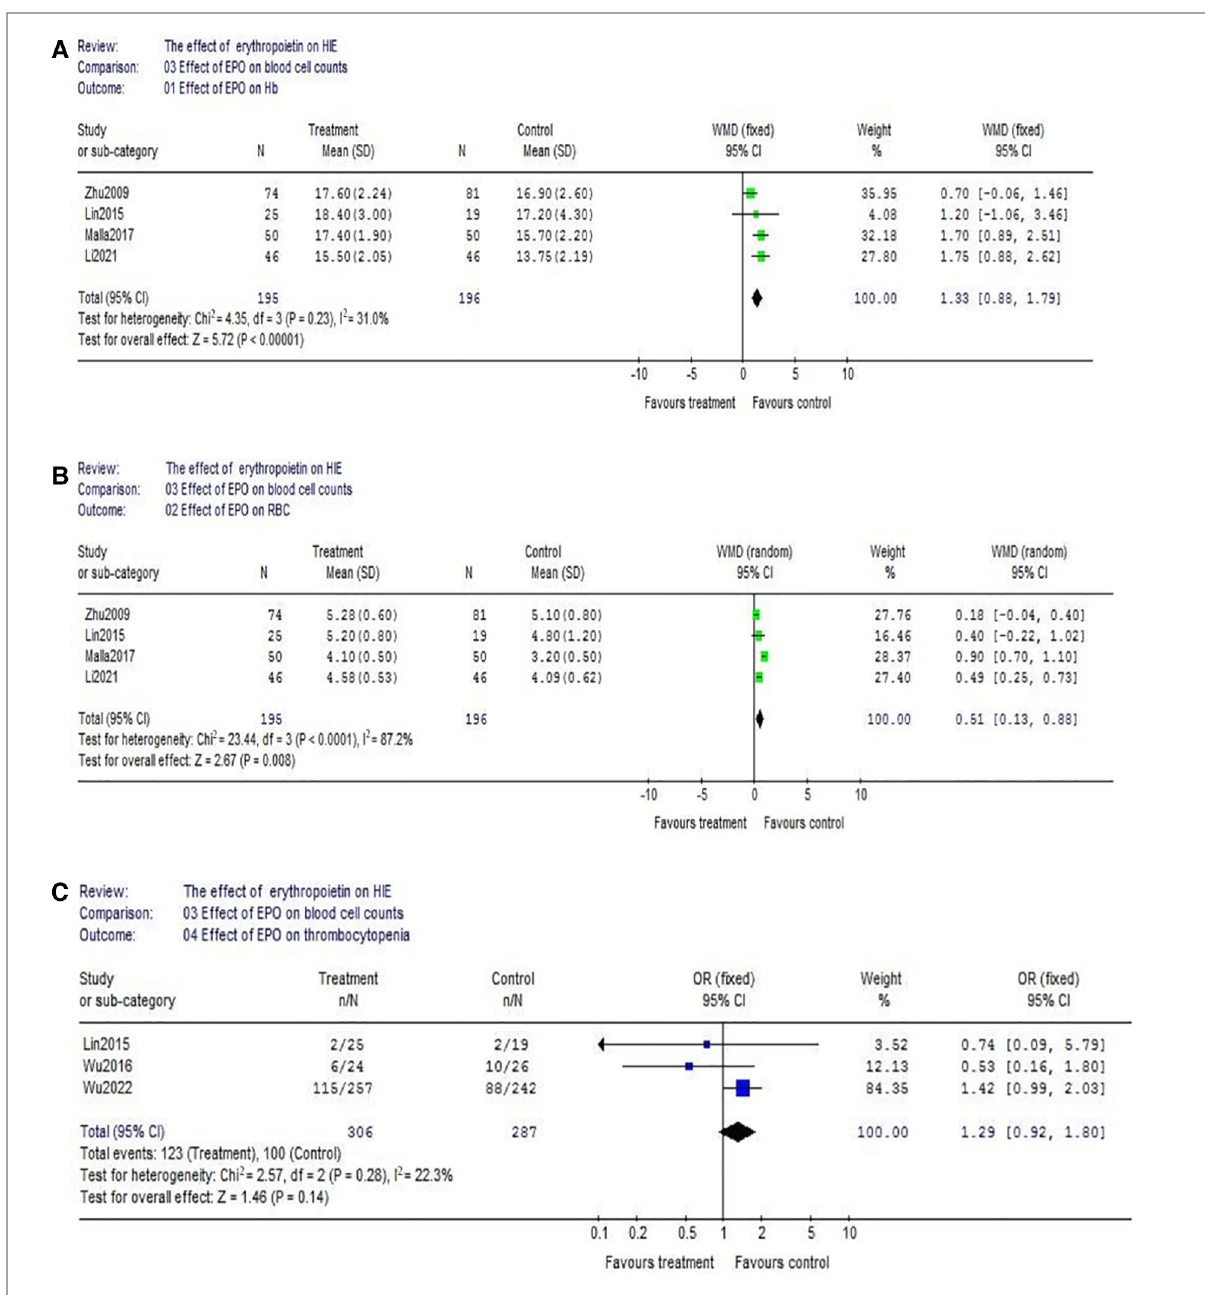
FIGURE 6 Effect of EPO on blood cell count change. ( A ) Effect of EPO on Hb; ( B ) Effect of EPO on RBC; ( C ) Effect of EPO on